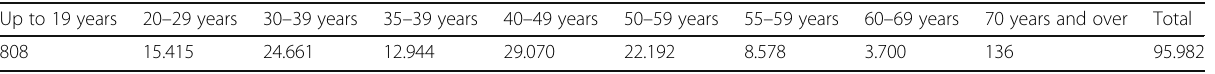
Table 2 Number of disability benefits granted by ICD M79 (and variants) distributed by age group Up to 19